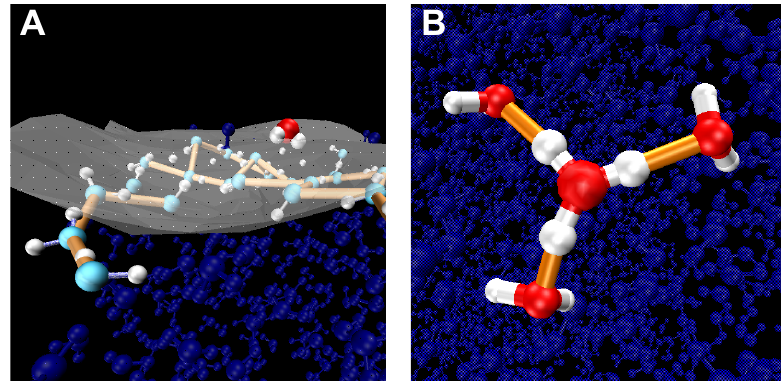
Figure 2. ( A ) Snapshot from DFT-MD highlighting the most probable position observed for H 3 O + surfing above the 2DN (2D-HBond-Network at the interface with the air). H 3 O + is depicted with red oxygen, water molecules in the 2DN with cyan oxygens. The instantaneous surface is also shown in gray-shade and the HBs forming the 2DN are highlighted in orange. ( B ) Snaphshot from DFT-MD simulations (top view) highlighting the most probable interfacial configuration of the hydronium, donating three HBs to three water molecules belonging to the 2DN and simultaneously pointing the O-atom towards the